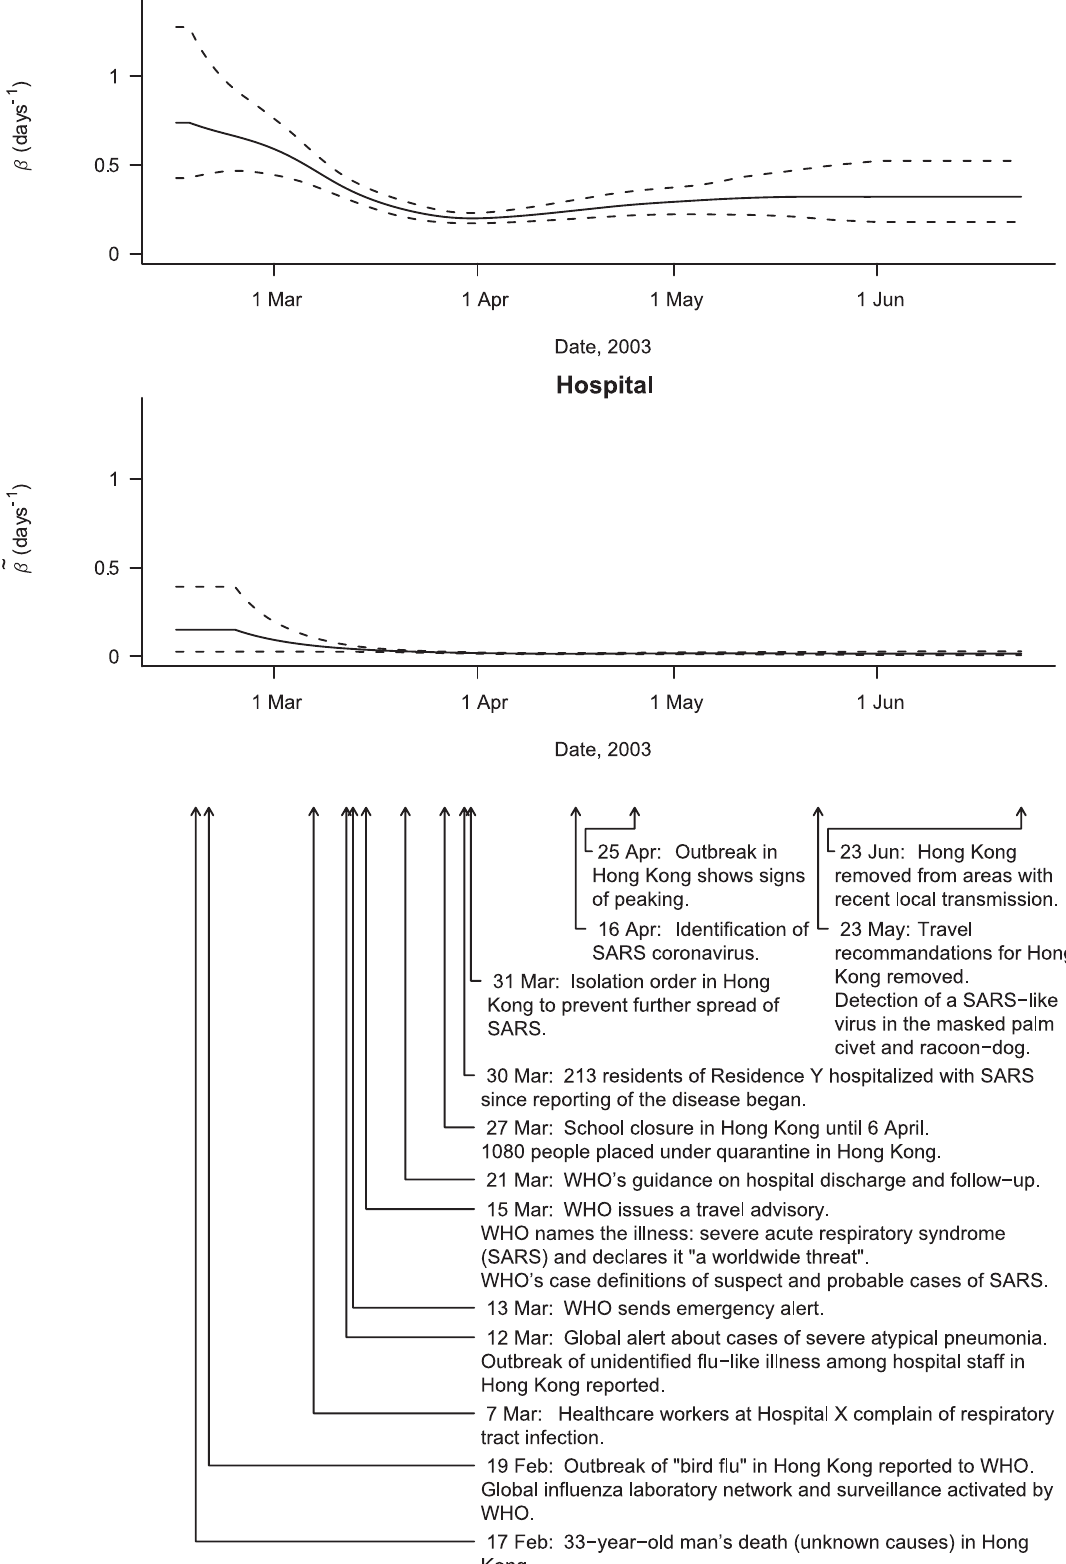
Figure 4. Mean Effective SARS Contact Rates (solid line) and 95% Credible Intervals (dashed line) in the Community and Hospitals as a Function of Time and Dates of Important Events.